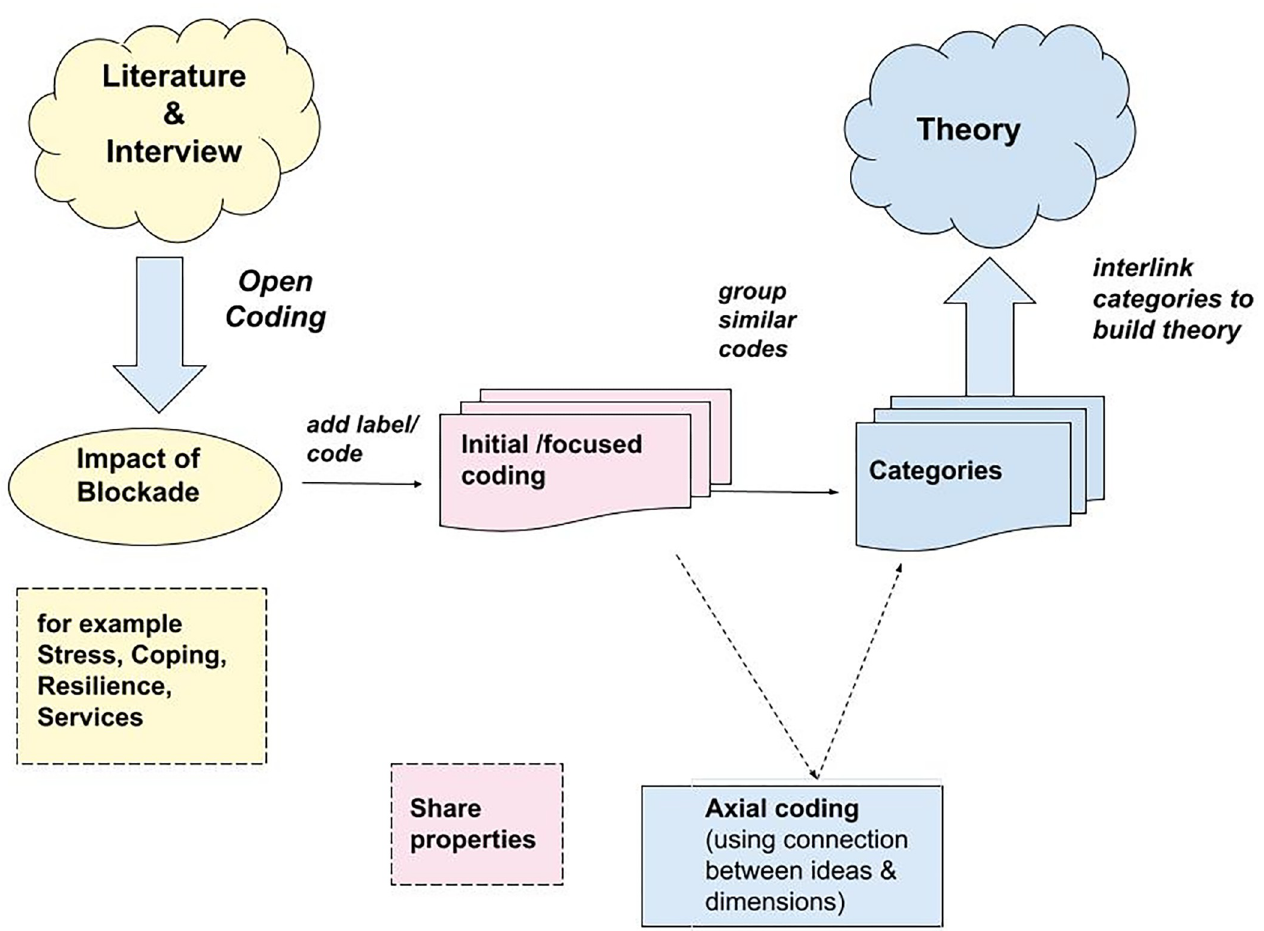
Fig 2. Coding tree. Literature and interviews on the impact of the Blockade are labeled during initial focused coding based on shared properties. Axial coding uses connections between ideas and dimensions groups similar codes and then categories are interlinked to build theory.